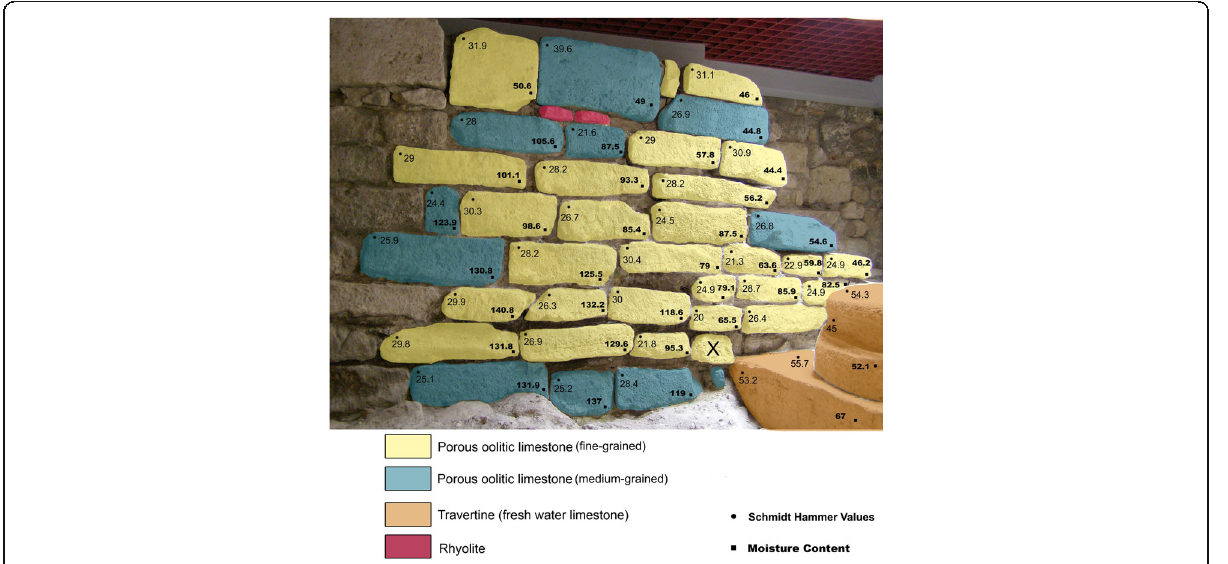
Fig. 6 Wall 1 — Schmidt hammer and moisture content